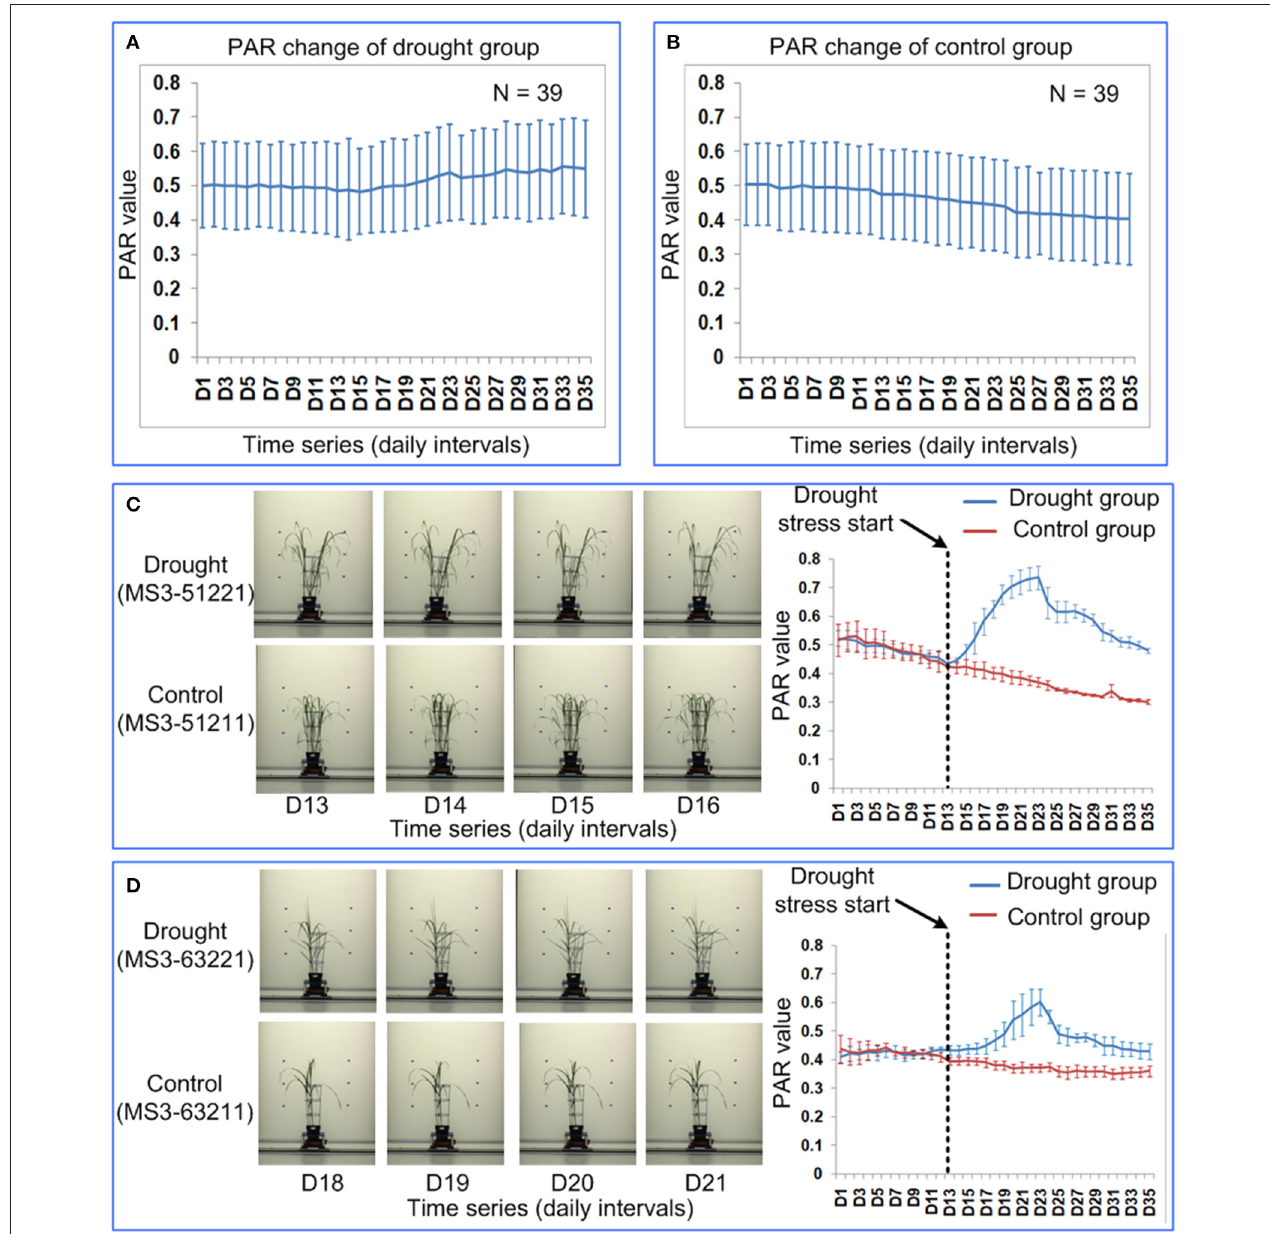
FIGURE 9 | Quantification of leaf-rolling for 39 Miscanthus accessions at daily intervals . Dynamics of PAR at 35 time points for (A) drought group and (B) control group. The markers and the bars in each line represent the mean value and standard deviation across the accessions, respectively. (C) Leaf-rolling performance and PAR change for a Miscanthus accession under drought (MS3-51221) and control (MS3-51211). (D) Leaf-rolling performance and PAR change for a Miscanthus accession under drought (MS3-63221) and control (MS3-63211). (C,D) Illustrate the difference in leaf-rolling performance among two accessions and the difference in PAR change in drought/control group for each accession. The markers and the bars represent the mean value and standard deviation for the 4 replications, respectively.